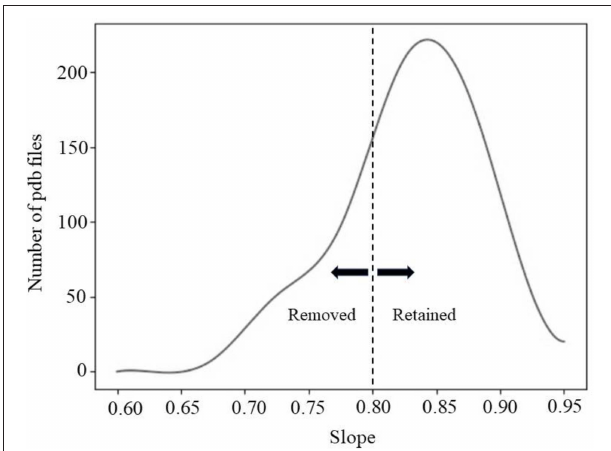
FIGURE 2 | The fitting line slope distribution of 550 protein